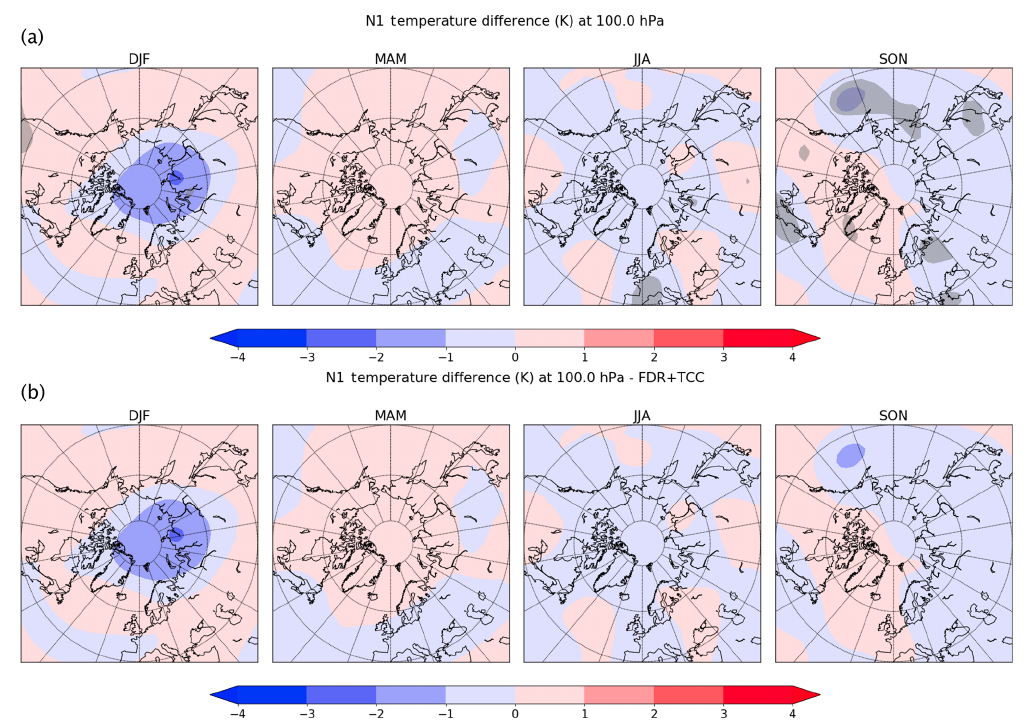
Figure 6. As Fig. 2 but for the 100hPa